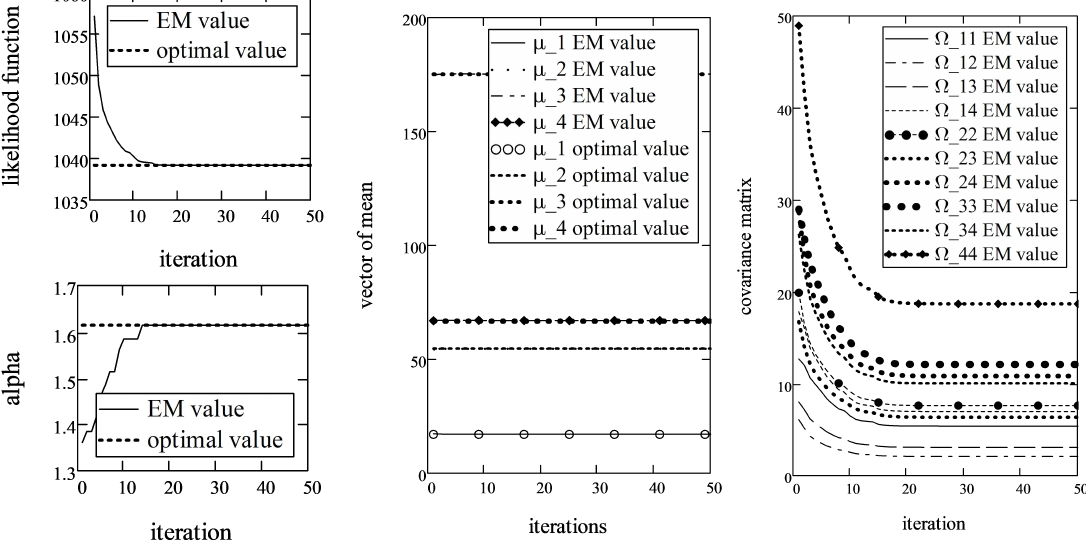
Figure 6. Dependence of the LLF and parameters’ MLE on the number of EM iterations, d = 4, K = 100.